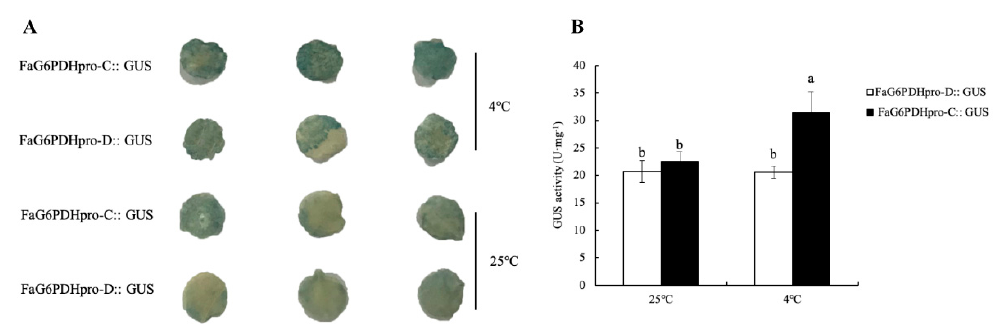
Figure 5. Beta-glucuronidase (GUS) activities in transgenic tobacco leaves under cold stress. FaG6PDHpro-C:: GUS and FaG6PDHpro-D:: GUS seedlings were kept at 4 ◦ C and 25 ◦ C for 48 h. Round leaf discs with a diameter of 1 cm punched from the treated tobacco leaves were performed histochemical staining ( A ) and quantification analysis ( B ) of GUS protein expression. Different lowercase letters indicate signi fi cant differences at p < 0.05.